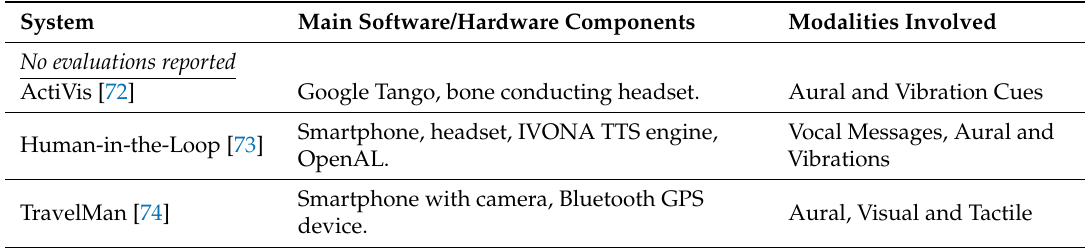
Table 2. Multimodal